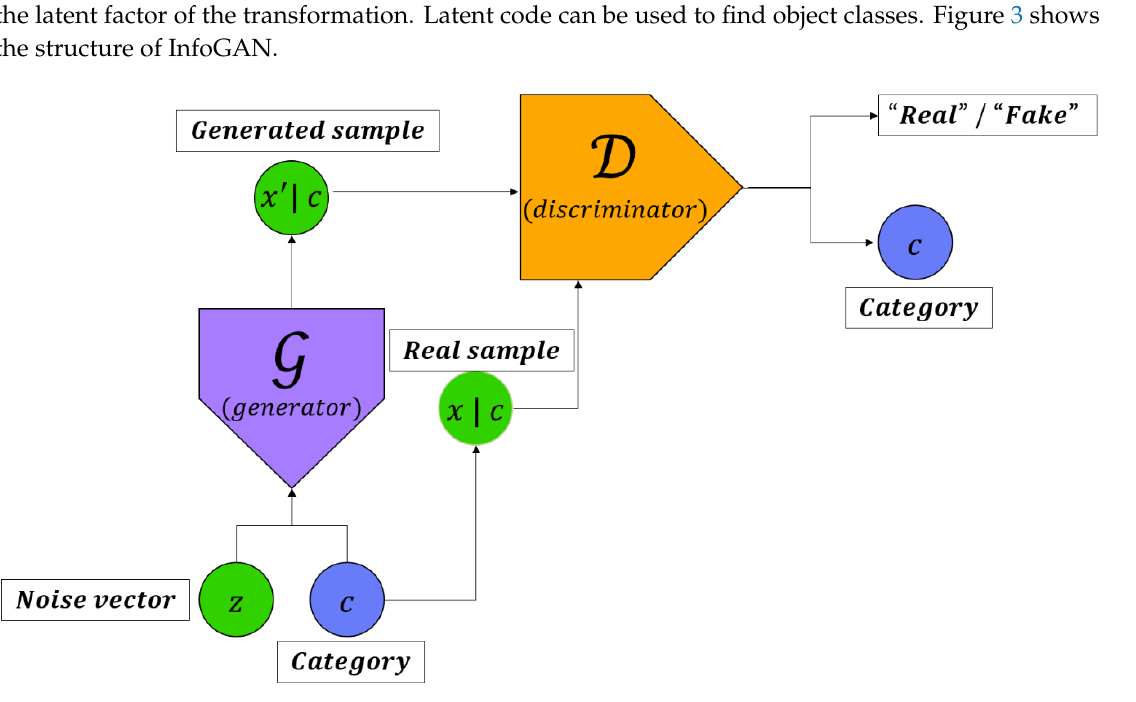
Figure 3. Structure and operation of InfoGAN (Information maximizing Generative Adversarial Network).